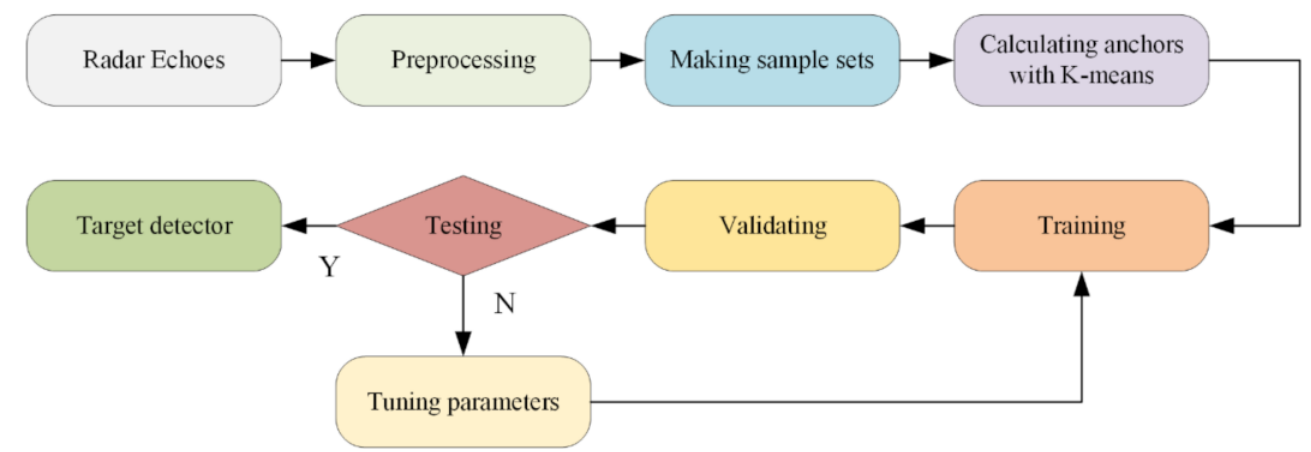
Figure 11. Flowchart of the target detection of the coastal defense radar based on the Faster